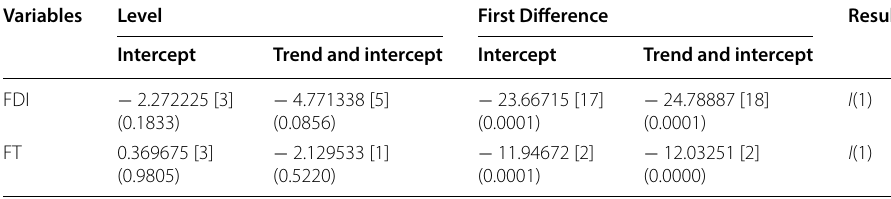
() MacKinnon (1996) one-sided p values; [] Lag lengths for PP Test; I (1): Stationary after first